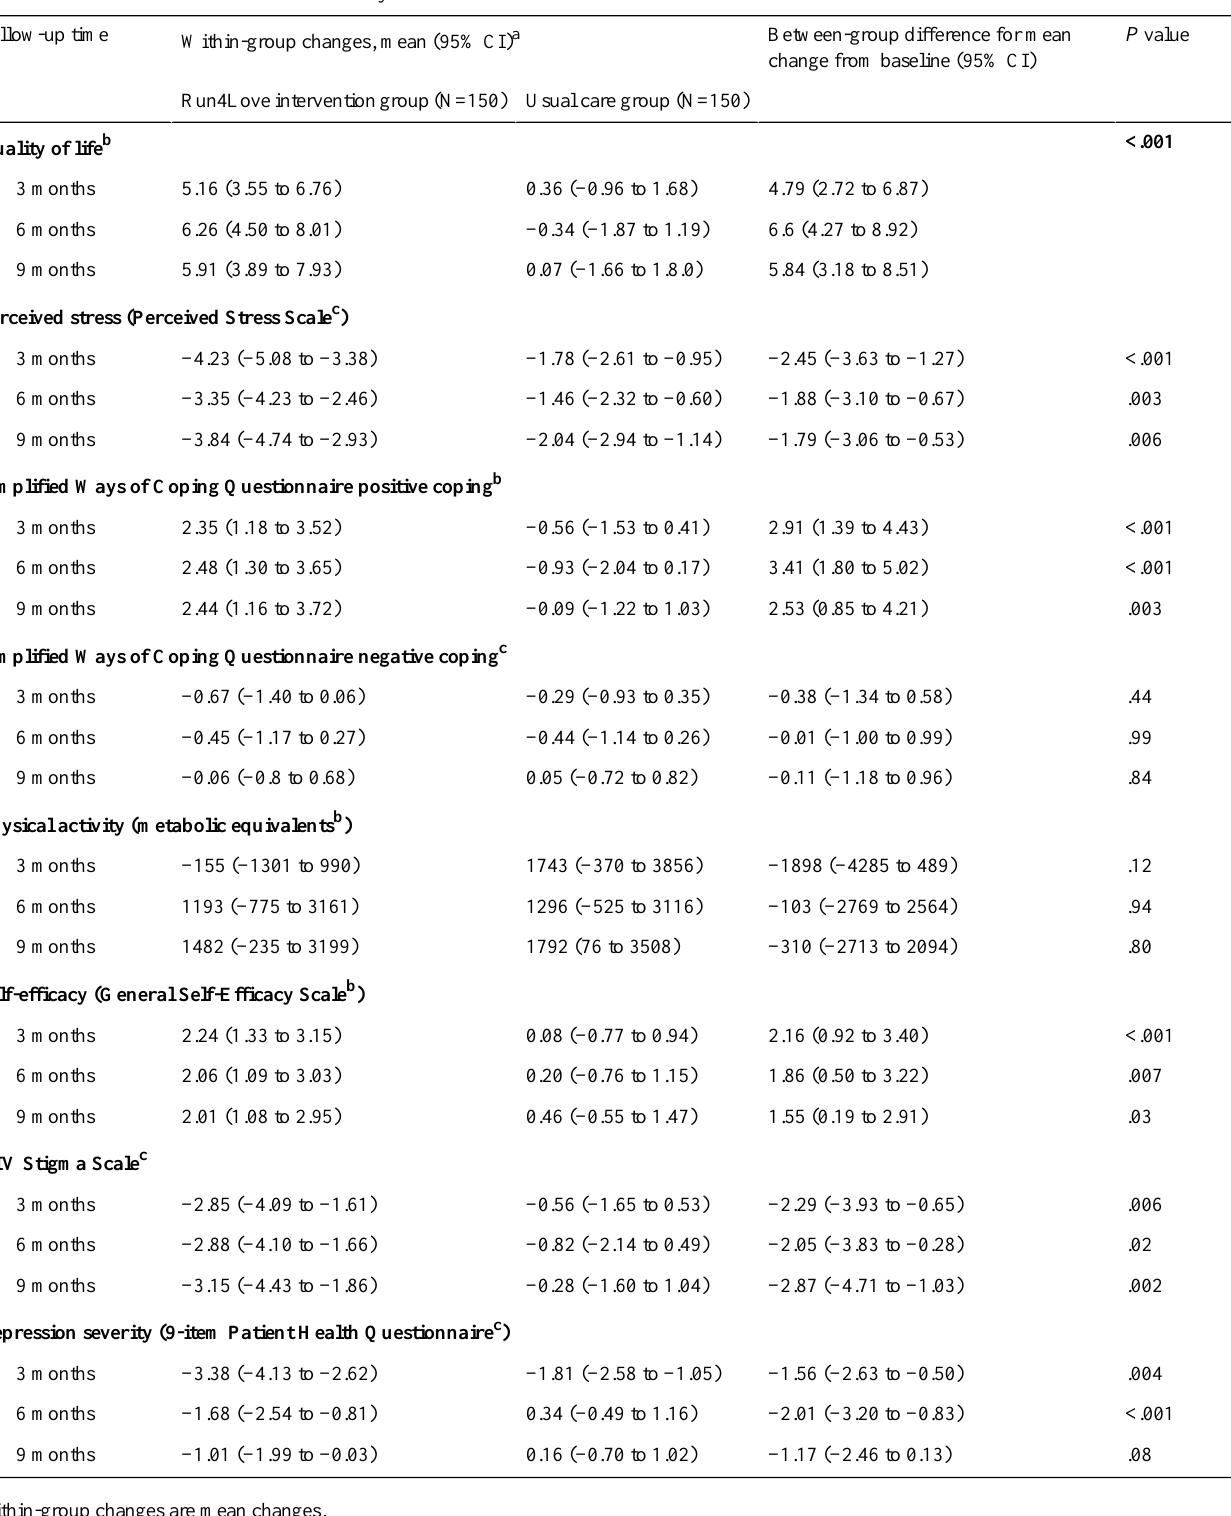
Table 3. Effects of the intervention on secondary outcomes.